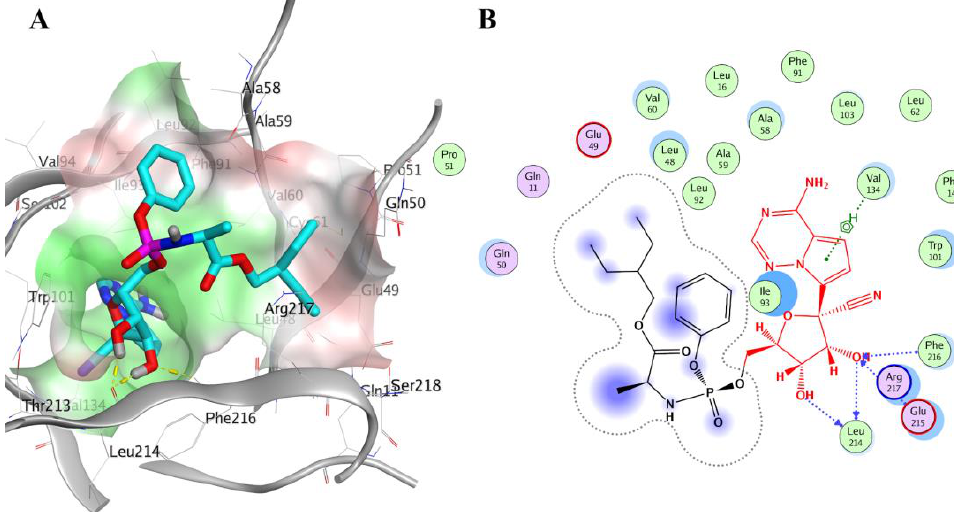
Figure 4. Docking pose of Remdesivir (DrugBank cyan sticks) in the Fascin binding site 2 (PDB ID: 6I18), represented by 3D and 2D as ( A , B ), respectively. Polar and non-polar areas of the pocket are shown in red and green colored molecular surfaces, respectively. Yellow dashed lines show the ligand interactions. Non-polar hydrogen atoms are ignored for clarification.